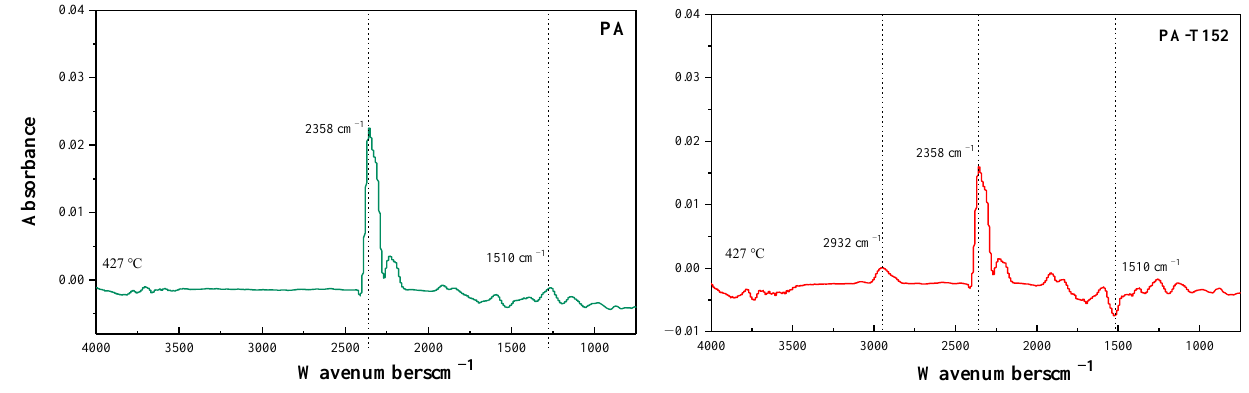
Figure 10. Three-dimensional TG-FTIR spectra of PA and PA-T152.